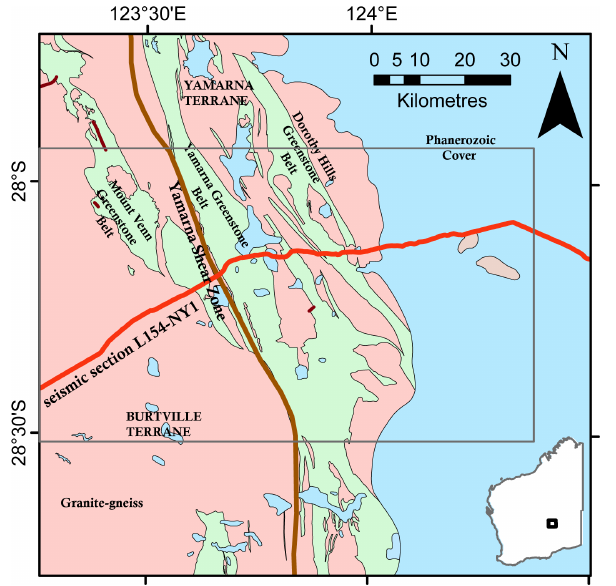
Figure 7. Geographical coordinates and geological units of the re- gion of interest in the Yamarna Terrane, eastern Yilgarn Craton, Albany–Fraser Orogen (modified from Lindsay et al., 2020). The gray rectangle shows the boundary of the region of interest in this study.